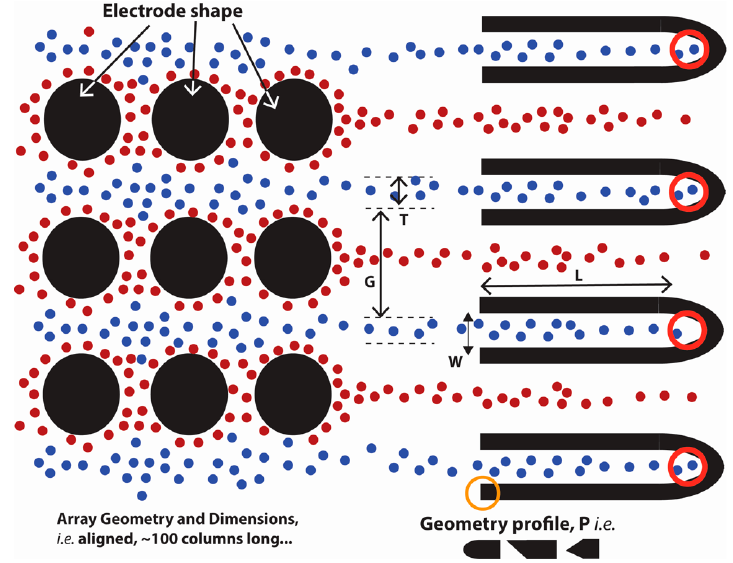
Figure 1. Schematic of the working principle of streaming Dielectrophoresis (DEP). Cells can be focused into streams of specific width T and separation G between each other. Retrieval geometries can be used for continuous extraction from the channel. The impact of device geometry and experimental parameters on the composition and width of the streams is studied here. Specifically, we study the impact of electrode shape (circles, diamonds, lens-shaped) and height (10%, 50% and 100% of the channel height) as well as flow rate and cell concentration in the sample.